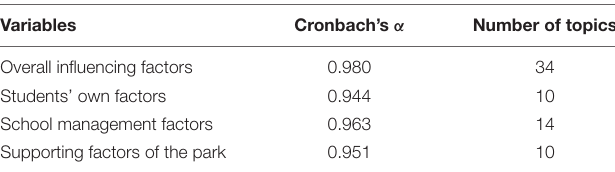
TABLE 3 | Reliability coefficient of the influencing factors of educational practice on preschool education majors in colleges and universities.